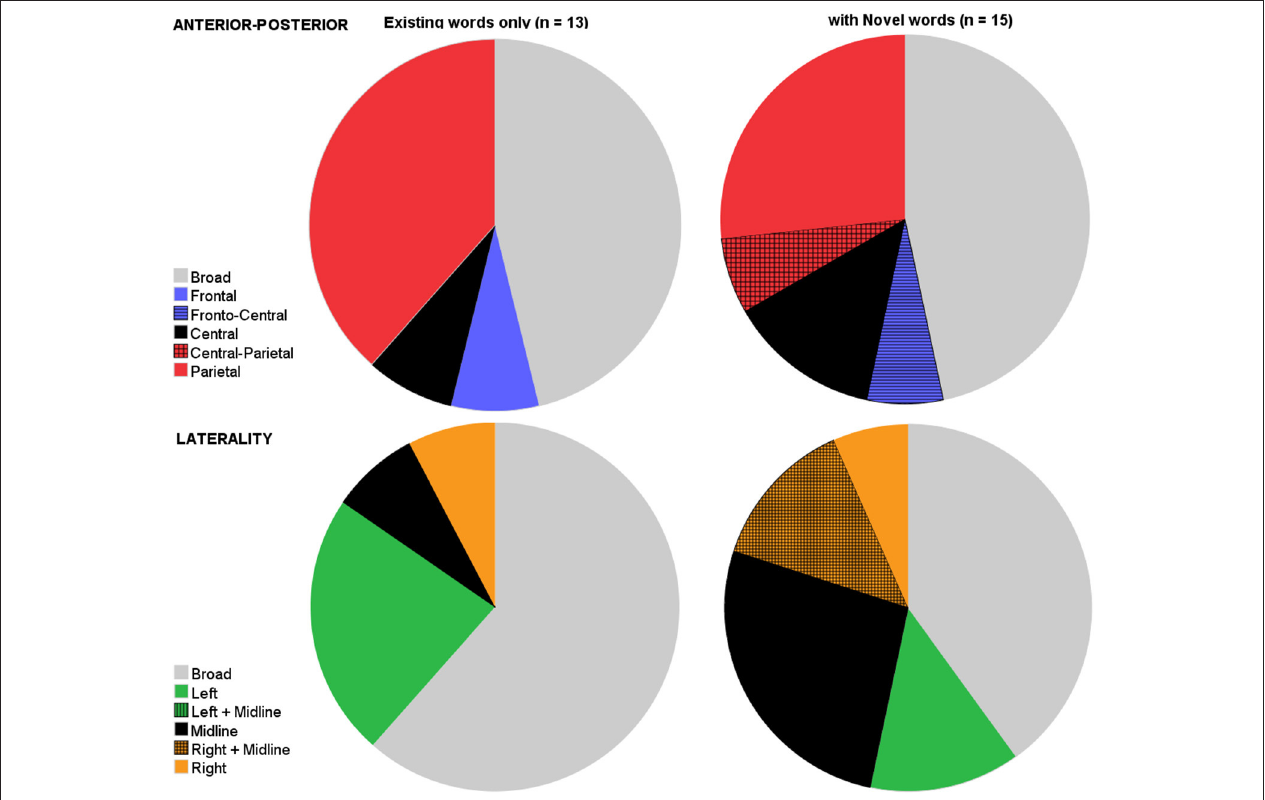
FIGURE 4 | Pie charts depicting the variation in studies on where on the scalp it is that the N400 priming effect is present (top row: anterior-posterior axis; bottom row: lateral axis) split by studies that either solely tested semantic processing of existing early words (left), or (also) included novel words (right).